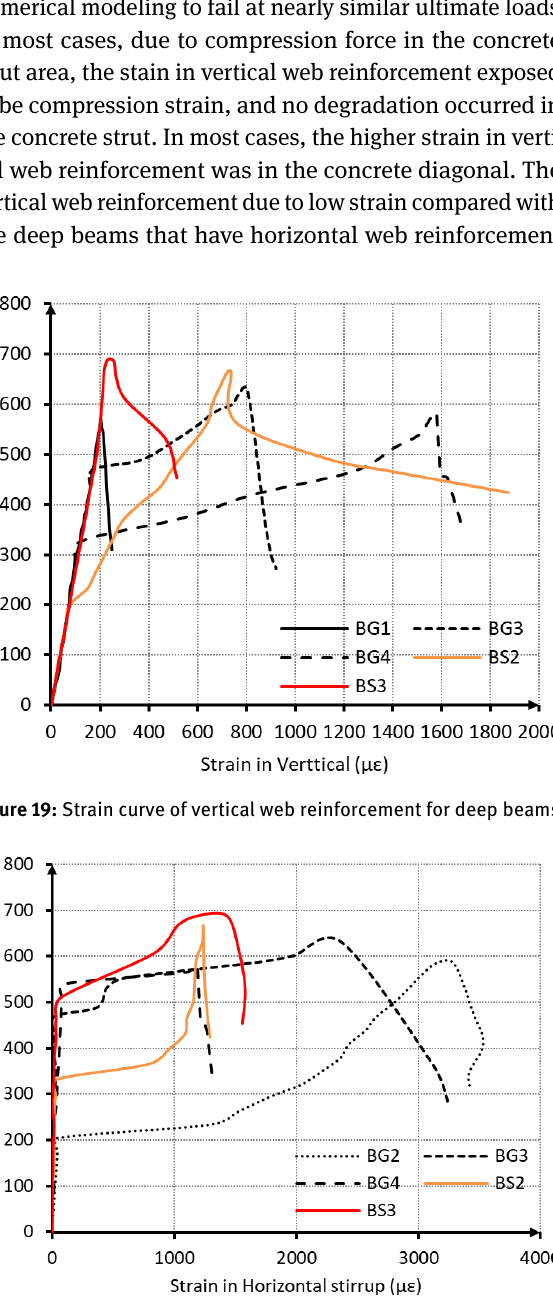
Figure 20: Strain curve of horizontal web reinforcement for deep